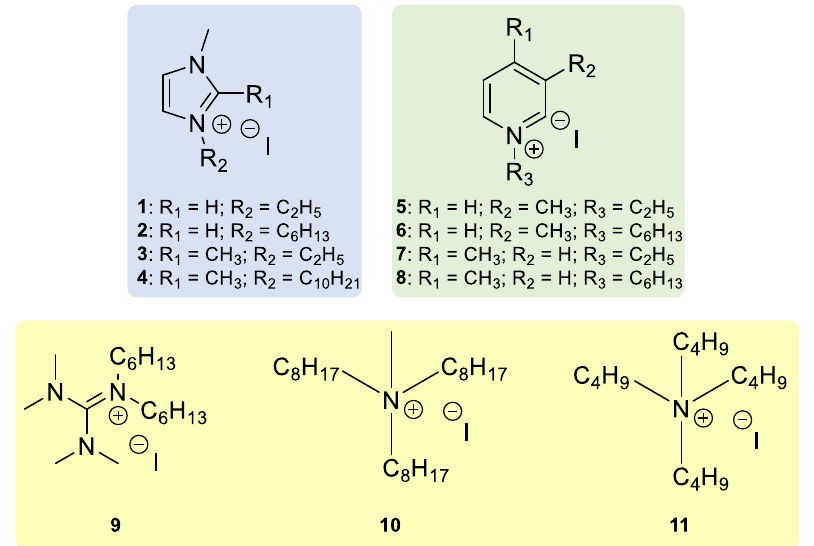
Figure 2. Chemical structures of the iodide-based organic salts synthesized and employed as additives in this